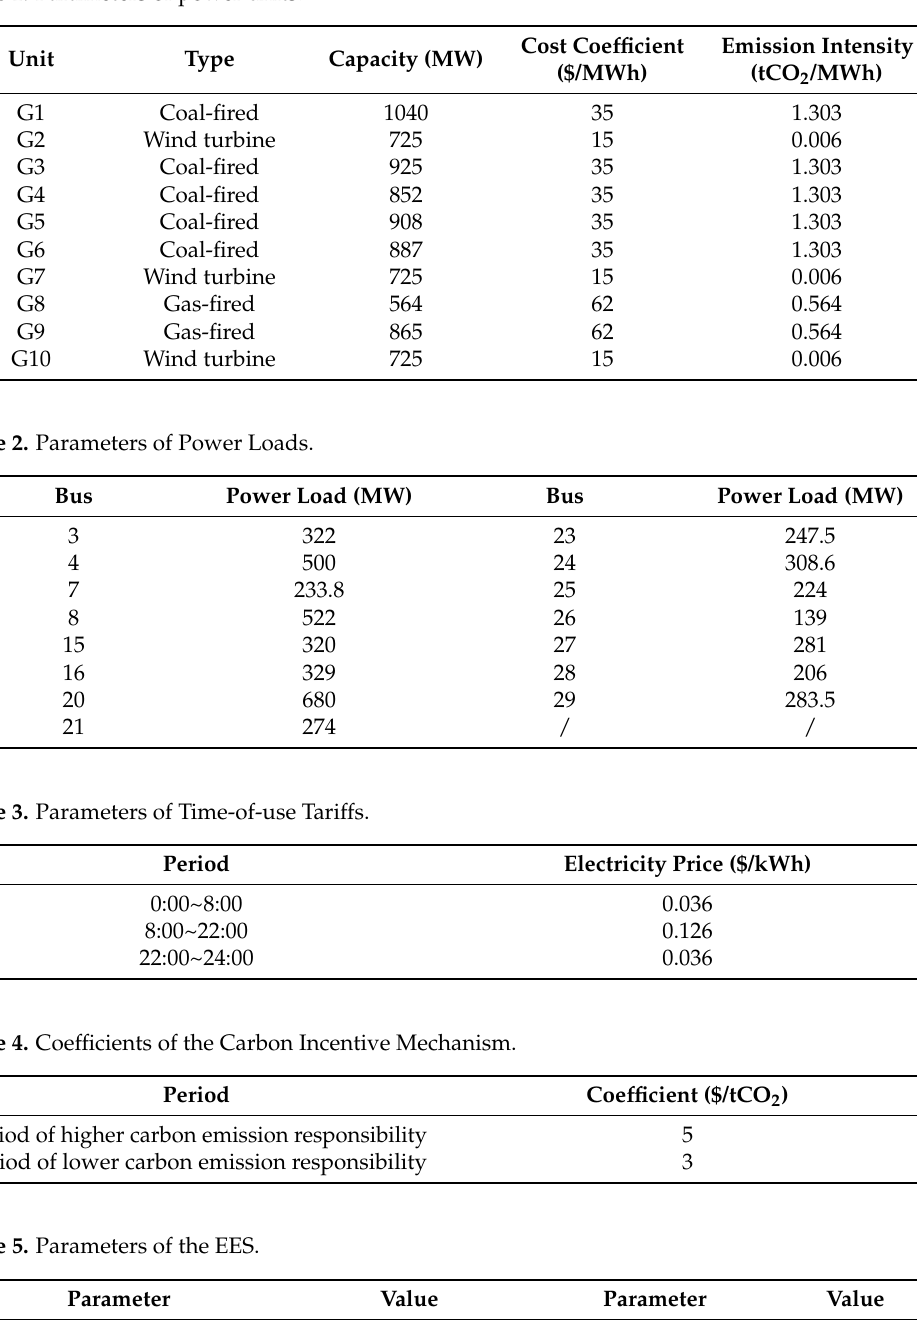
Table 1. Parameters of power units.